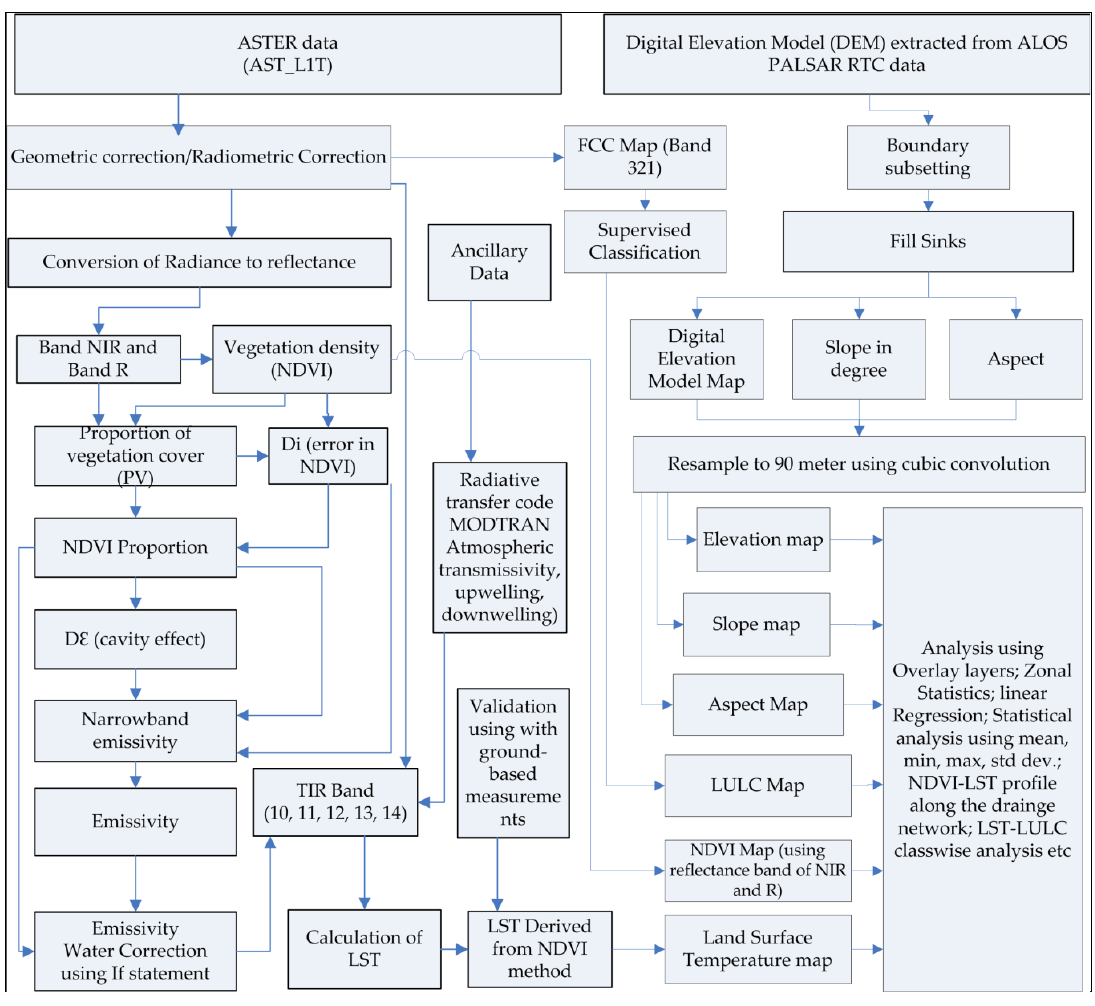
Figure 2. Flow diagram for the adopted methodology .